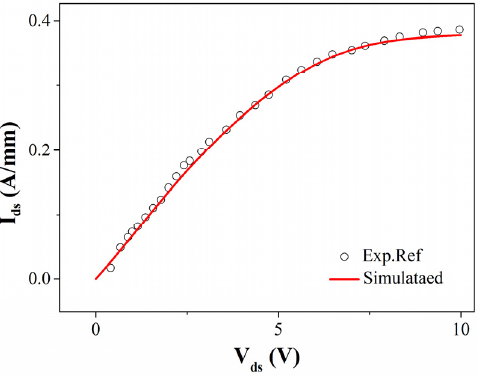
Figure 2. Output characteristics of InAlN/GaN HEMT from simulation and experimental results.